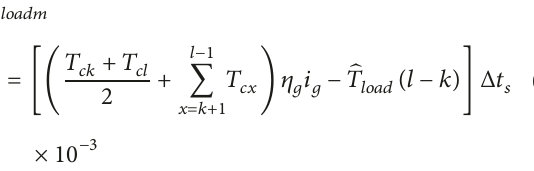
transmitted torque. The signal of the transmission output shaft speed sensor can be collected after the signal gear turns the first tooth. The speed of the transmission output shaft can be measured as long as the output shaft turns. The load resistance torque can be calculated until the transmission control unit collects the first output shaft speed signal during the starting